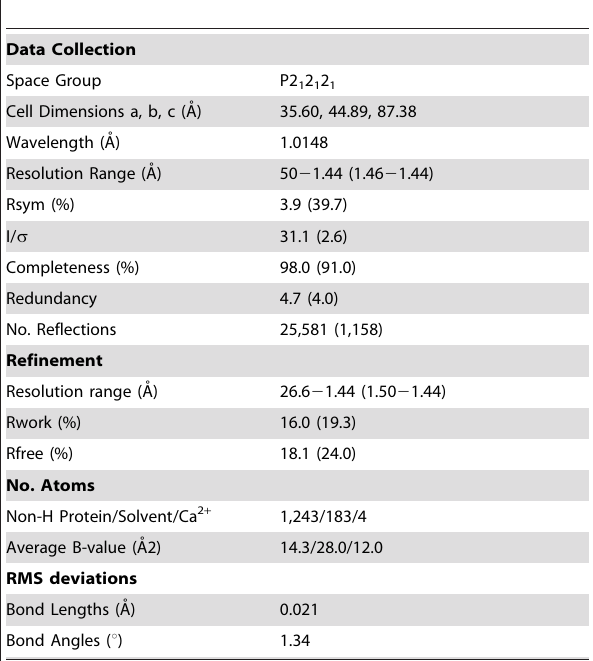
Table 1. Refinement Statistics for the crystal structure of the synaptotagmin-7 C 2 B